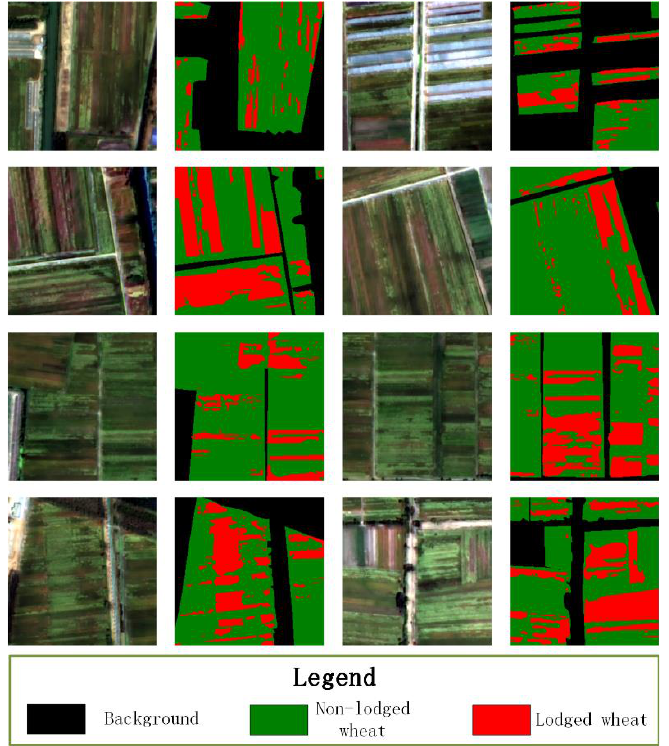
Figure 3. Illustration of the labeled ground truth on the satellite image.